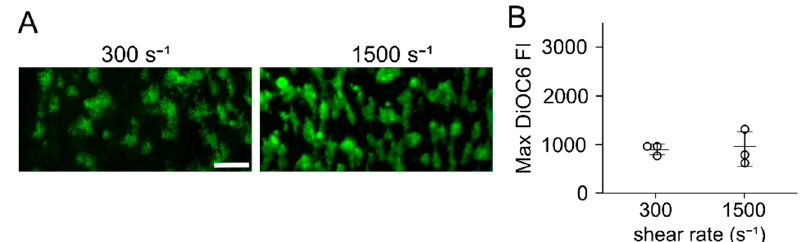
Figure 2. Microfluidic flow assays with microspot patterning. ( A ) Representative images of platelet accumulation on collagen peptides patterned on glass by microspotting after a 5 min perfusion at wall sheare rates of 300 s − 1 and 1500 s − 1 . Scale bar = 50 µm. ( B ) Maximum fluorescence intensity of assays for n = 3.